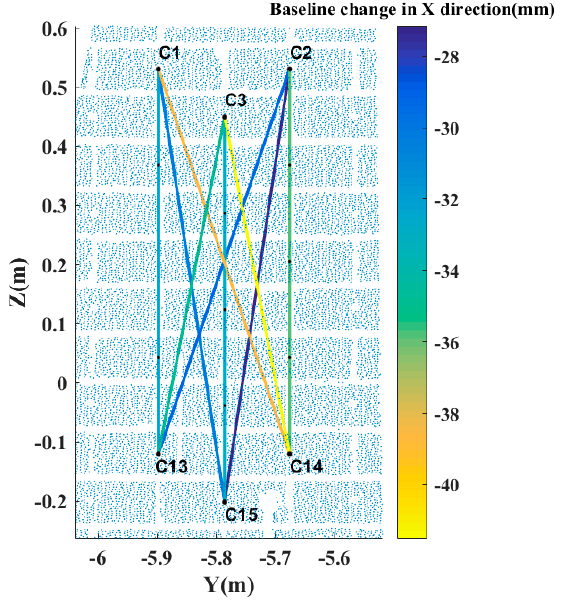
Figure 15. Baselines change in the X direction in patch Figure 15 . Baselines change in the X direction in patch C.